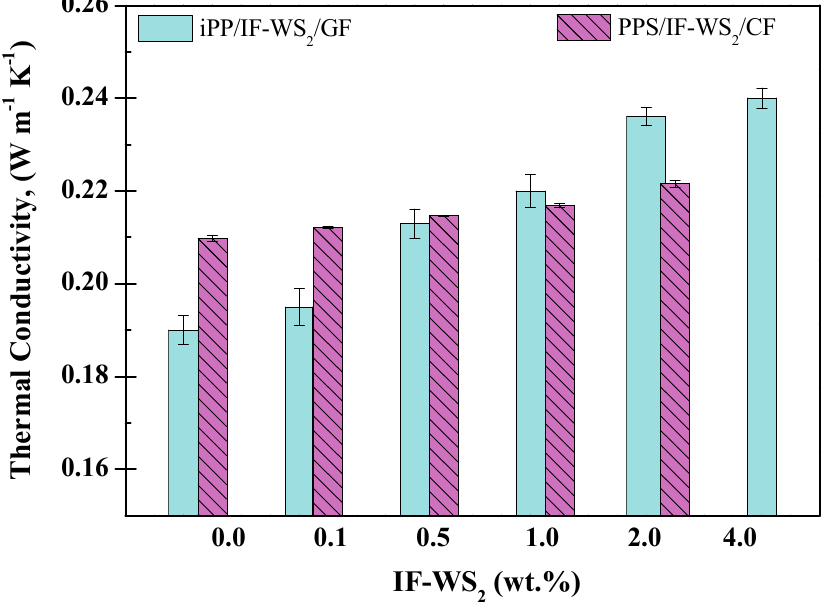
Figure 4. Room temperature thermal conductivity of iPP and PPS-based laminates as a function of IF-WS 2